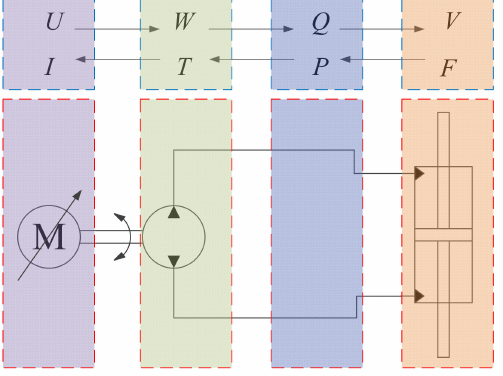
Figure 1. Schematic of servo pump-controlled energy